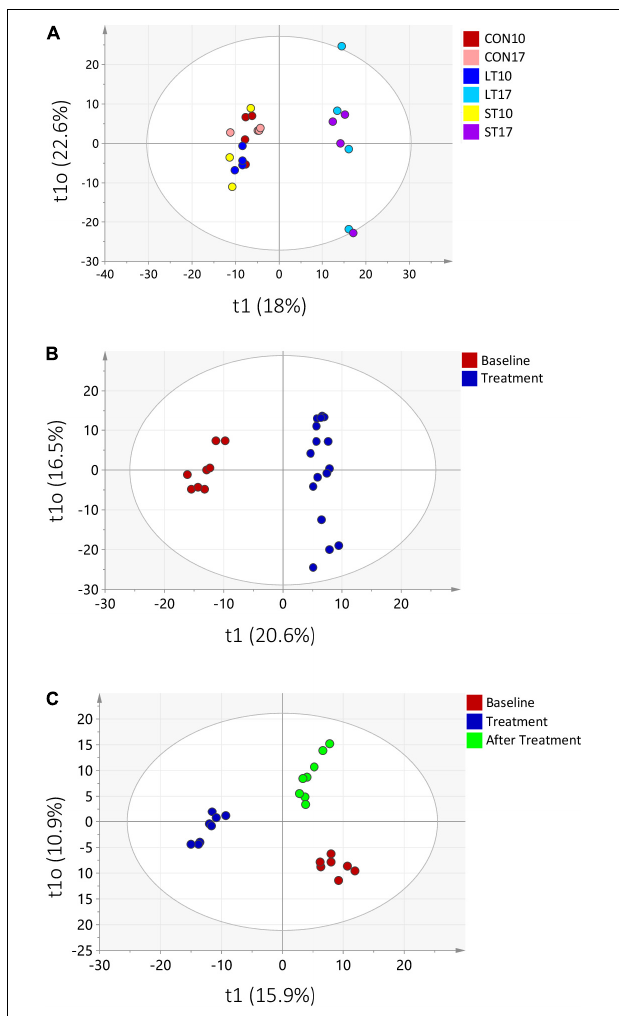
FIGURE 6 | Orthogonal projections to latent structures discriminant analysis plot of the metabolomics analysis (A) for all three treatment groups at days 10 and 17, (B) the long term (LT) group at days 17–38 (Treatment) vs. LT and CON at day 10 (BL) and (C) the short term (ST) group at days 17 and 24 (Treatment), at days 31 and 38 (After Treatment) vs. CON and ST at day 10